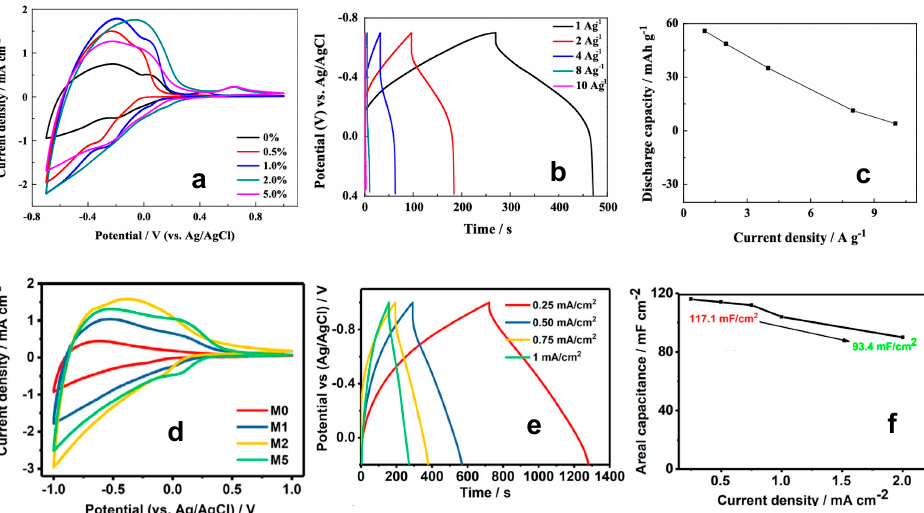
Figure 8. ( a ) CV curves of Mo-doped WO 3 nanowires as a function of the Mo concentration, ( b ) GCD curves of electrodes obtained with 2% of Mo-doped WO 3 nanowires, and ( c ) related discharge capacity as a function of current density [54]; ( d ) CV curves of Mo-doped WO 3 thin film as a function of Mo concentration; ( e ) GCD curves of the electrodes obtained by using a composite in which the atomic ratio between Mo and W is equal to 0.02 (M2); ( f ) related areal capacitance as a function of current density [70]. Reproduced with permission.